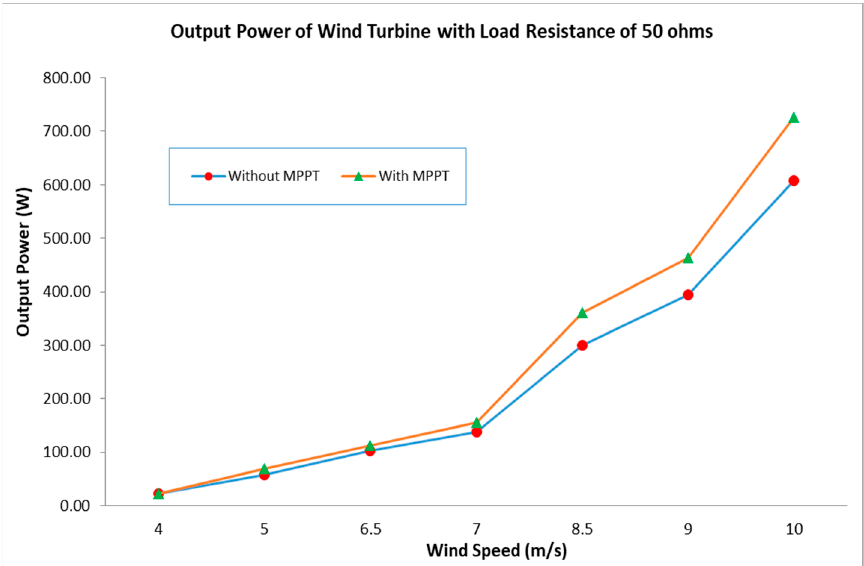
Figure 14. Output power of wind-turbine system with load resistance of 50 Ω .